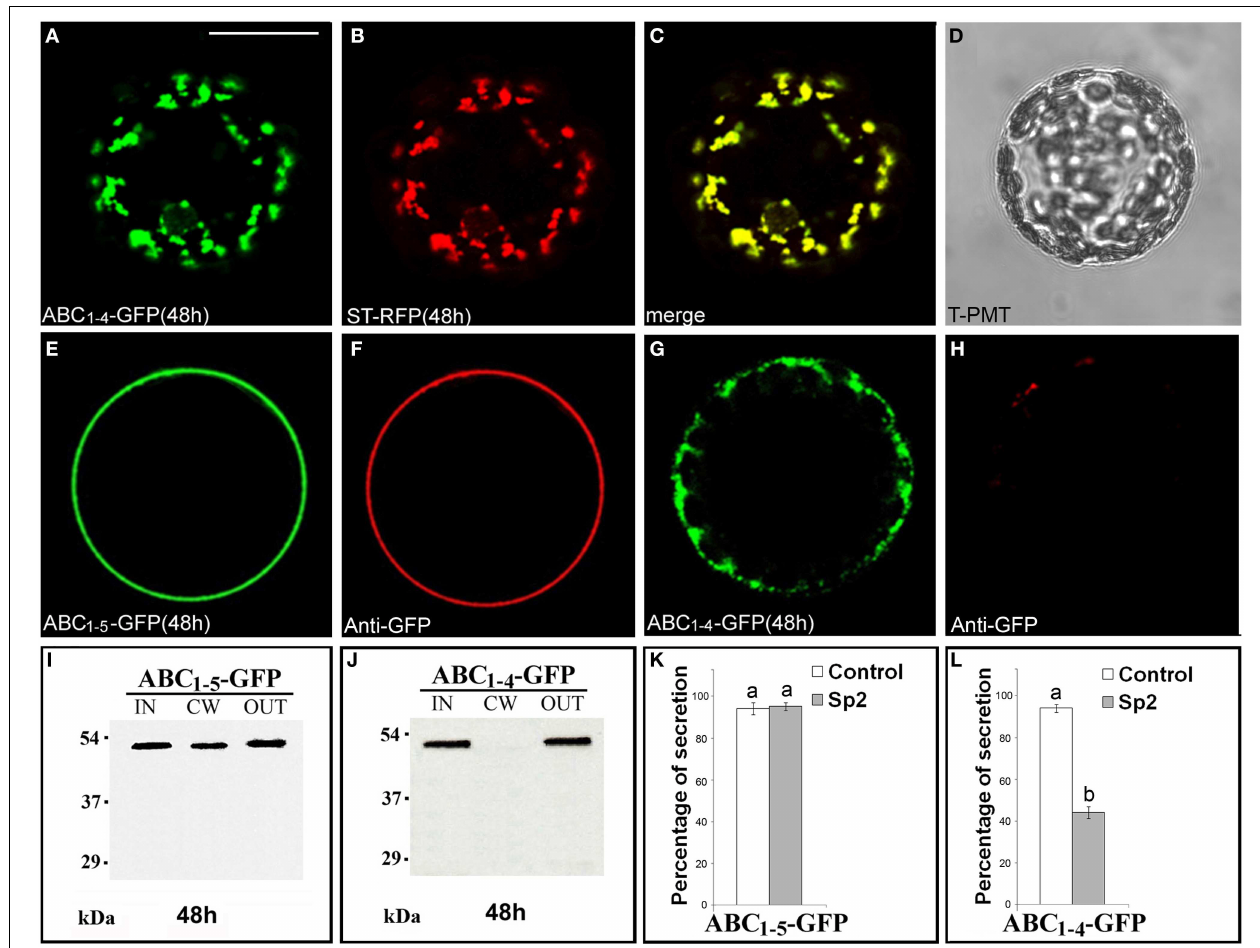
fluorescence immunolabeling was observed in 89 ± 5% among over 300 transformed protoplasts examined. Three independent transformation experiments were performed for each construct, and approximately 100 transformed protoplasts were counted each time. (I,J) Western blot of protein fractions (intracellular, IN; cell wall, CW; incubation medium, OUT) obtained from tobacco protoplast transformed with ABC 1–5 -GFP (I) and ABC 1–4 -GFP (J) . (K,L) Quantification of the effect of Sp2 on the secretion of ABC 1–5 -GFP (K) and ABC 1–4 -GFP (L) . Statistical analysis is as in Figure 1 . Bands were detected using anti-GFP serum. Scale bars = 20 µ